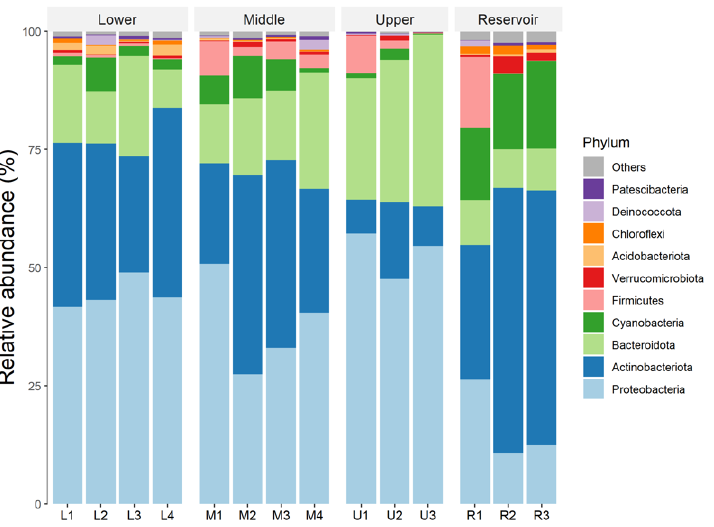
Figure 4. The relative abundance of dominant bacterial phyla (top 10) in the water samples.